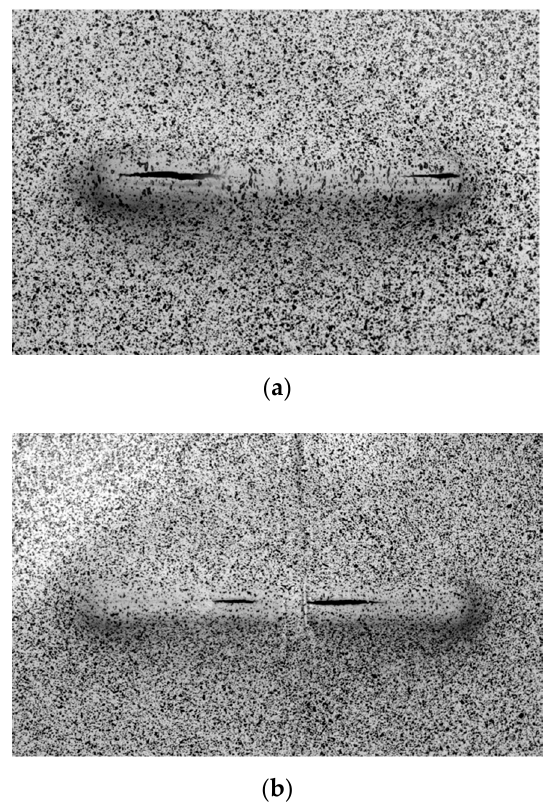
Figure 12. The specimens immediately after the crack occurred for unwelded blanks ( a ) and double side welded blanks ( b ) for uniaxial tool path test.